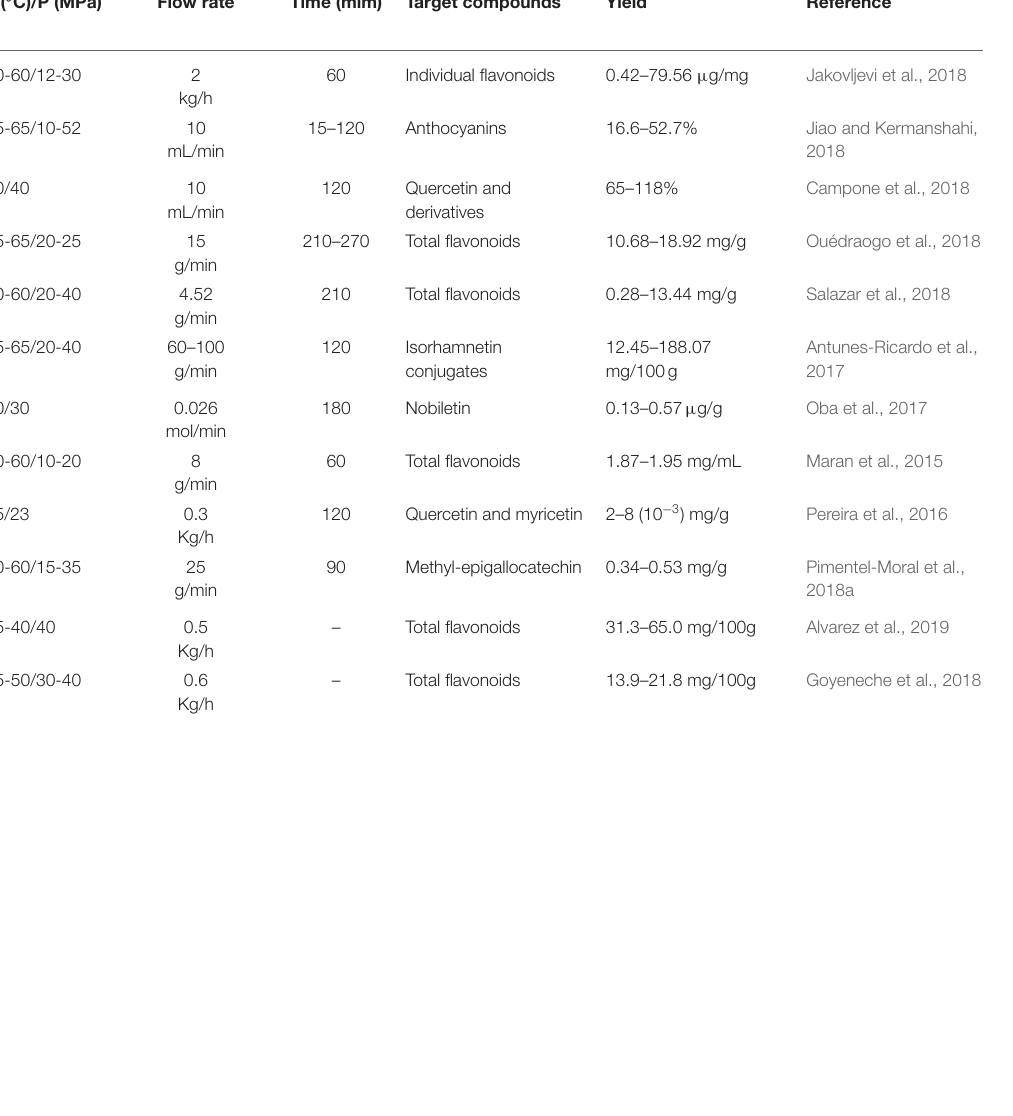
TABLE 6 | Some representative applications involving the use of SFE for the recovery of flavonoids from natural sources. Natural source of